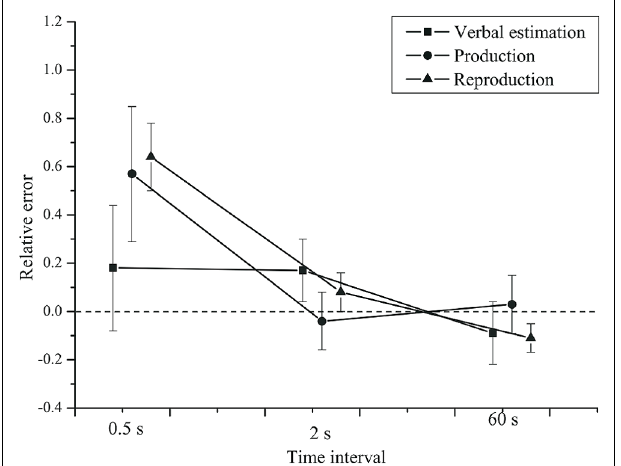
FIGURE 1 | Mean relative error as a function of time interval and task. Squares: verbal estimation. Circles: production.Triangles: reproduction. Error bars show 95% confidence